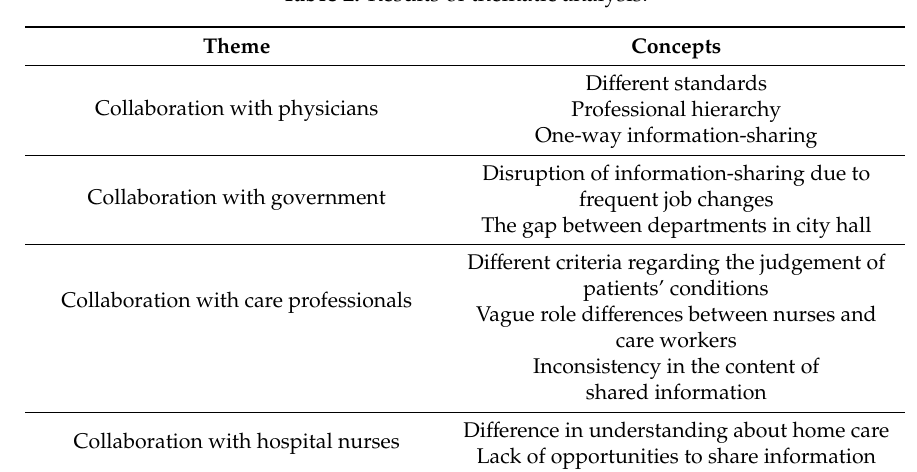
Table 2. Results of thematic